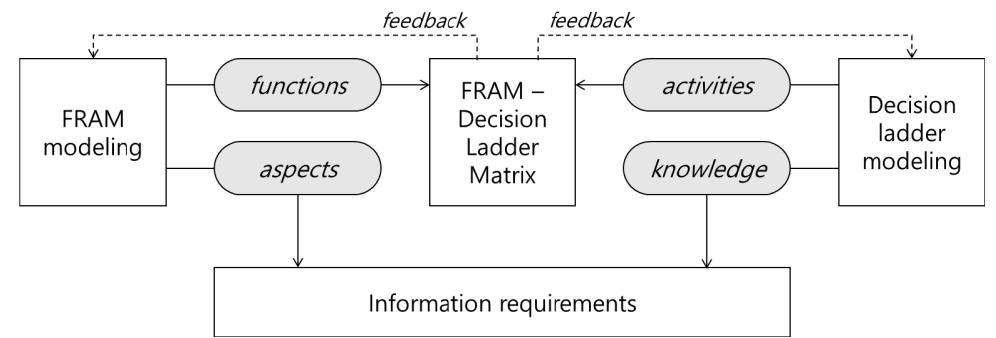
Figure 2. Information requirements development approach.